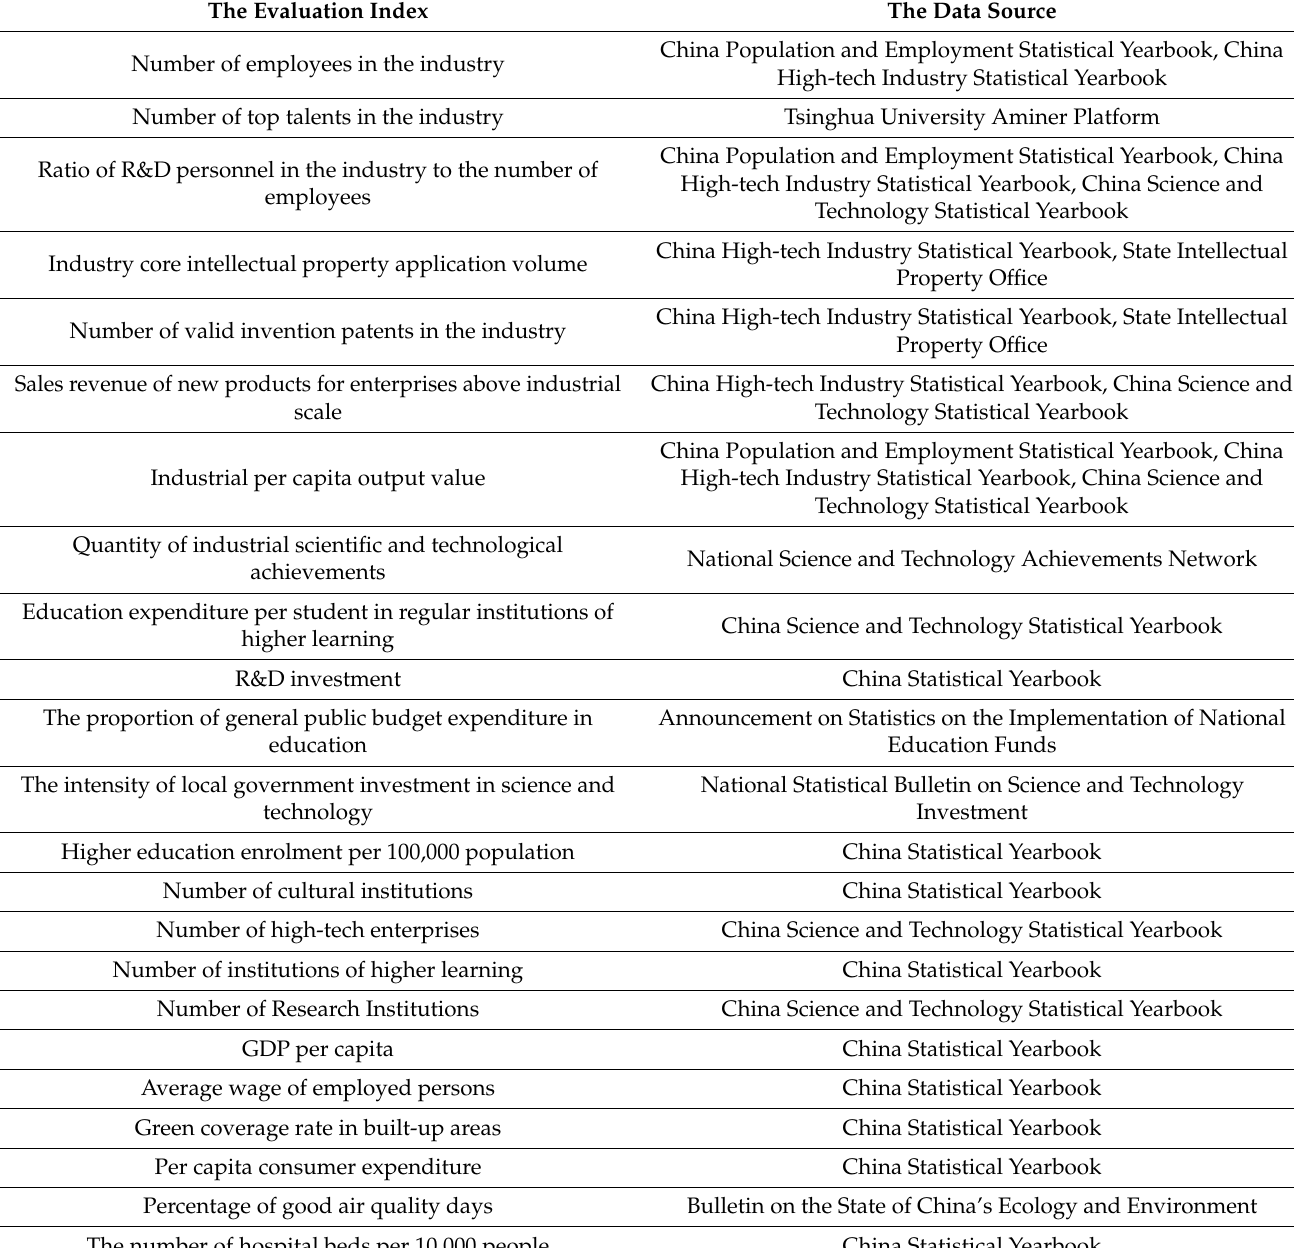
Table 3. Data sources of evaluation